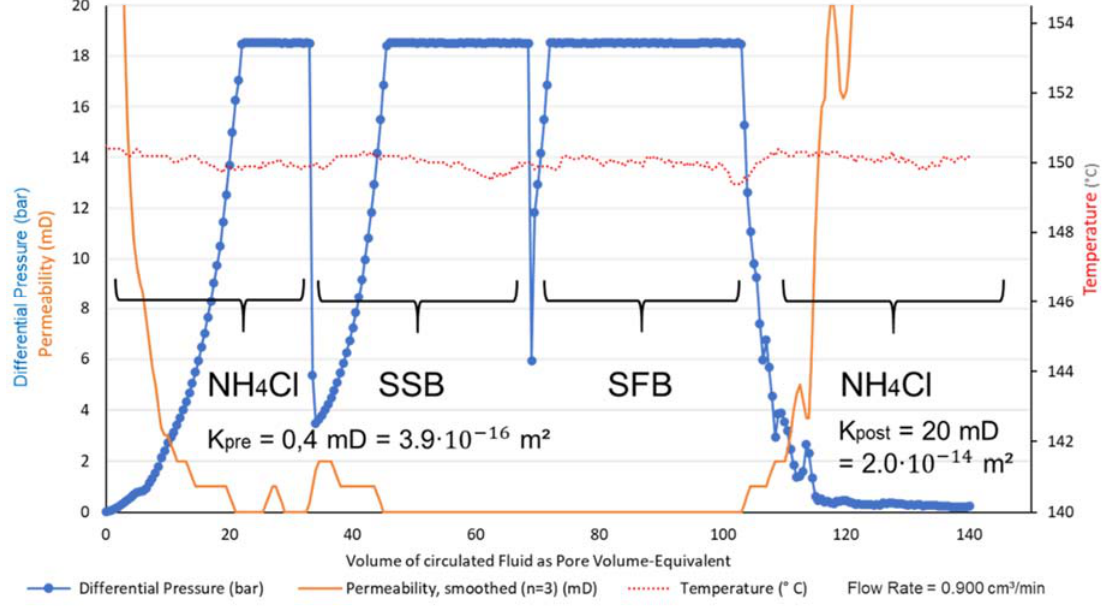
Figure 8. Pore volume—differential pressure diagram showing the development of the CFT on sample 3, applied flow rate: 0.900 mL/min; modified after [44].